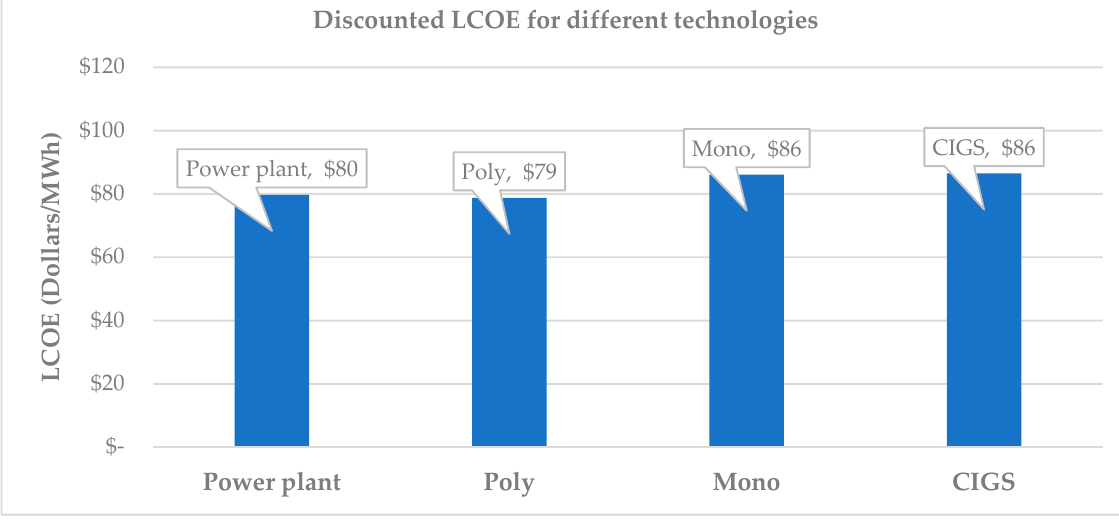
Figure 13. Discounted LCOE for each technology.